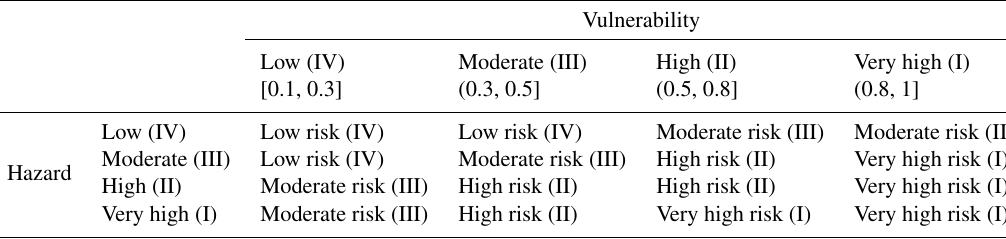
Table 8. Risk matrix method for assessing storm surge